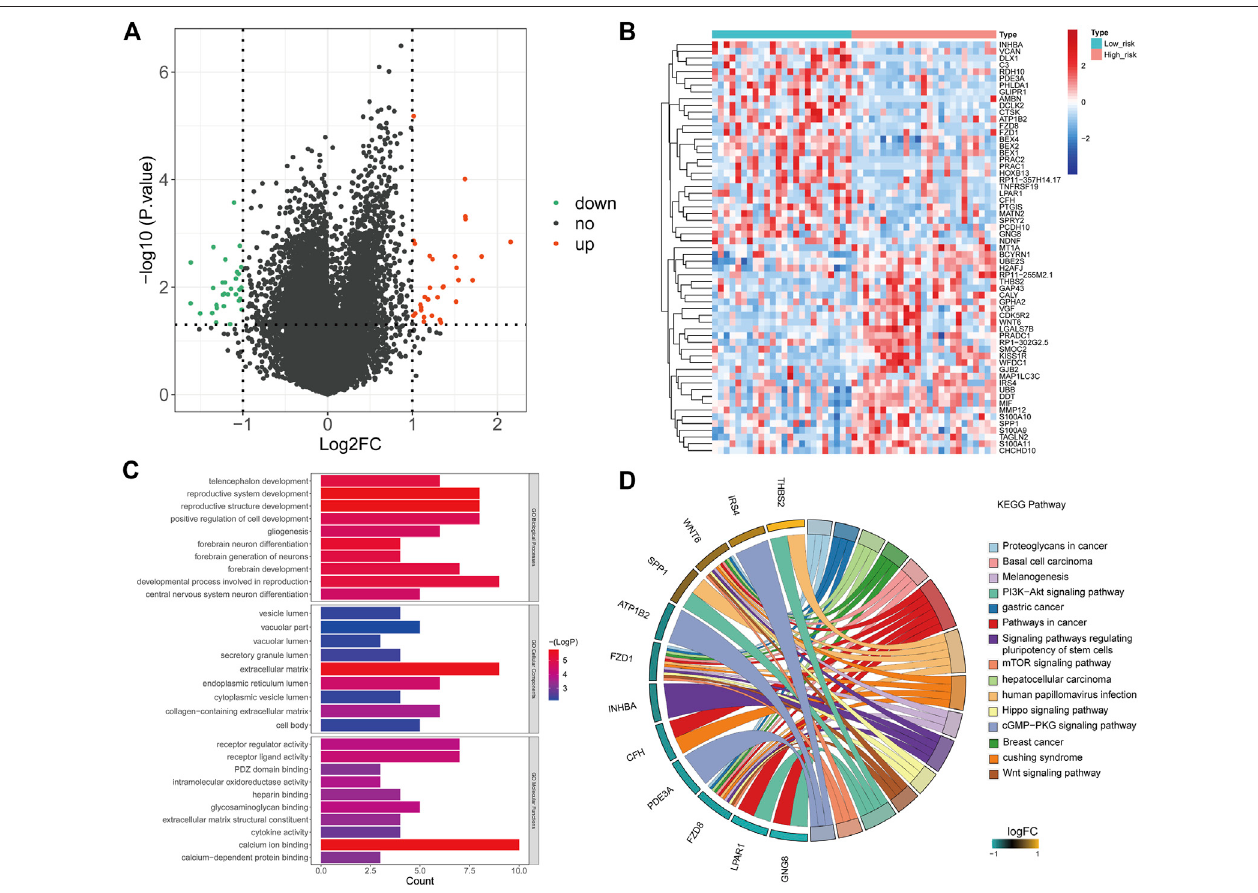
FIGURE 5 | Functional enrichment analysis. (A) Volcano plot showing the DEGs of the risk score (high vs. low). Green: downregulated (Down), red: upregulated (Up), black: unchanged (no). (B) Heatmap based on 61 DEGs that were differentially expressed between high- and low-risk score samples. Each column represents a sample, and each row represents the mRNA level. Red indicates that the gene is upregulated, and green indicates downregulated genes. (C) Top 10 Gene Ontology terms enriched by the DEGs. (D) KEGG enrichment analysis of DEGs. The left side of the circle is the gene, and the right side is the pathway. Different colors representdifferentpathways, andthe colorofeach pathway isannotatedin rightofthecircle.Ifthe genebelongs toapathway, there will bealinebetween thegeneand the pathway.